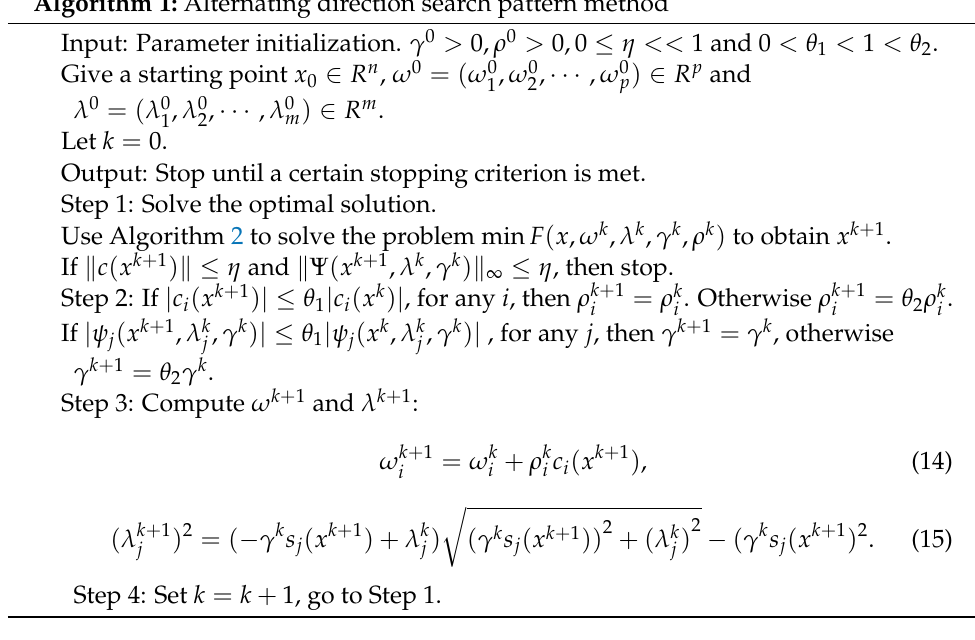
Algorithm 1: Alternating direction search pattern method